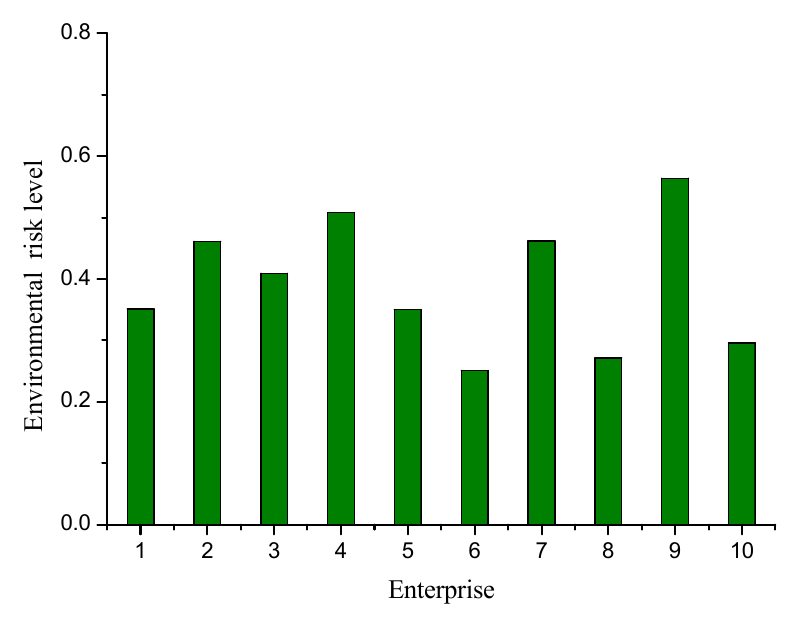
Figure 3. Comprehensive risk levels of chemical enterprises in Songmu Island Chemical Industrial